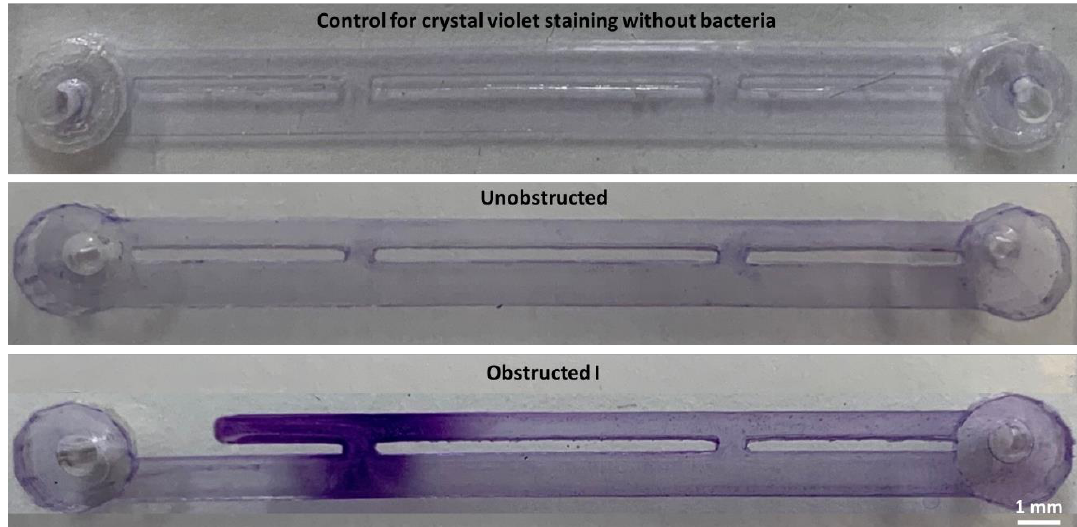
Figure A2. Photographs of crystal violet staining in whole stent-on-a-chip devices. The control test shows no significant unspecific staining of crystal violet on the inner surfaces of the device. The unobstructed device shows no bacterial attachment upon flowing the bacterial suspension for 1 h, while the obstructed I device shows bacterial attachment in the cavity region.